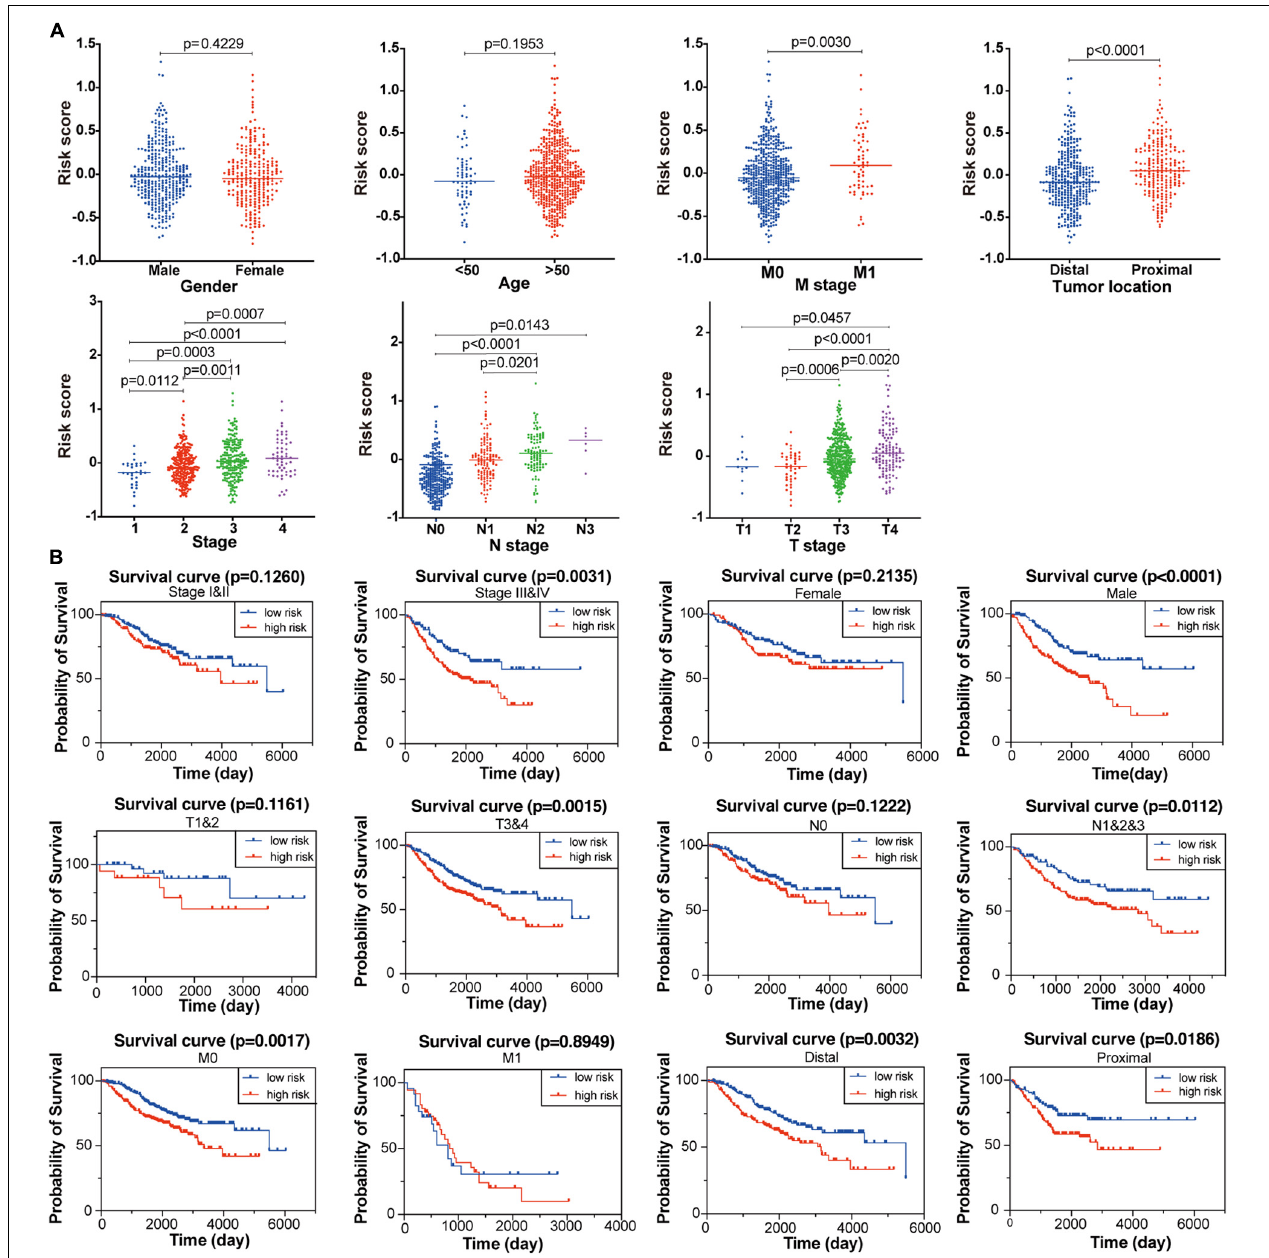
FIGURE 4 | Association between the established FRG signature and clinicopathological characteristics. (A) Correlation analyses of risk scores calculated based on the FRG signature with multiple clinicopathological features of CC patients in the GSE39582 dataset, including gender, age, stage, tumor location, T stage, N stage and M stage. Statistical significance was calculated using the Student’s t -test ( p < 0.05). (B) Subgroup Kaplan-Meier curve analysis shows overall survival probability of high- and low-risk CC patients from the GSE39582 dataset stratified by stage (stage I/II vs. stage III/IV), gender (female vs. male), T stage (T1/2 vs. T3/4), N stage (N0 vs. N1/2/3), M stage (M0 vs. M1), and tumor location (distal vs. proximal). Statistical significance was calculated using the log-rank test ( p <